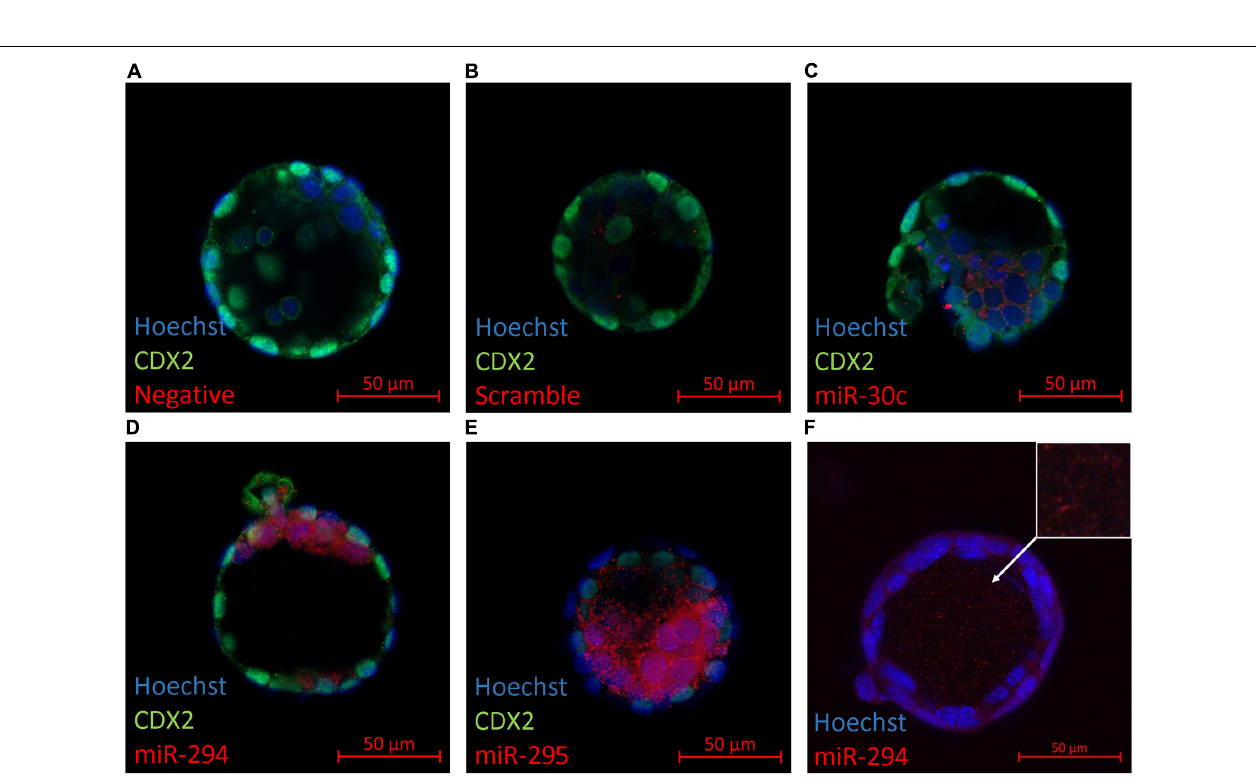
FIGURE 2 | In situ localization of select miRNAs in late-stage blastocysts. Localization of three mature miRNAs (miR-30c, miR-294, and miR-295) within the late-stage expanded blastocyst (116 h post-hCG) is presented. Representative images are of (A) No probe negative control, (B) scramble probe negative control, (C) miR-30c, (D) miR-294, (E) miR-295, and (F) miR-294 in the blastocyst cavity (orthogonal